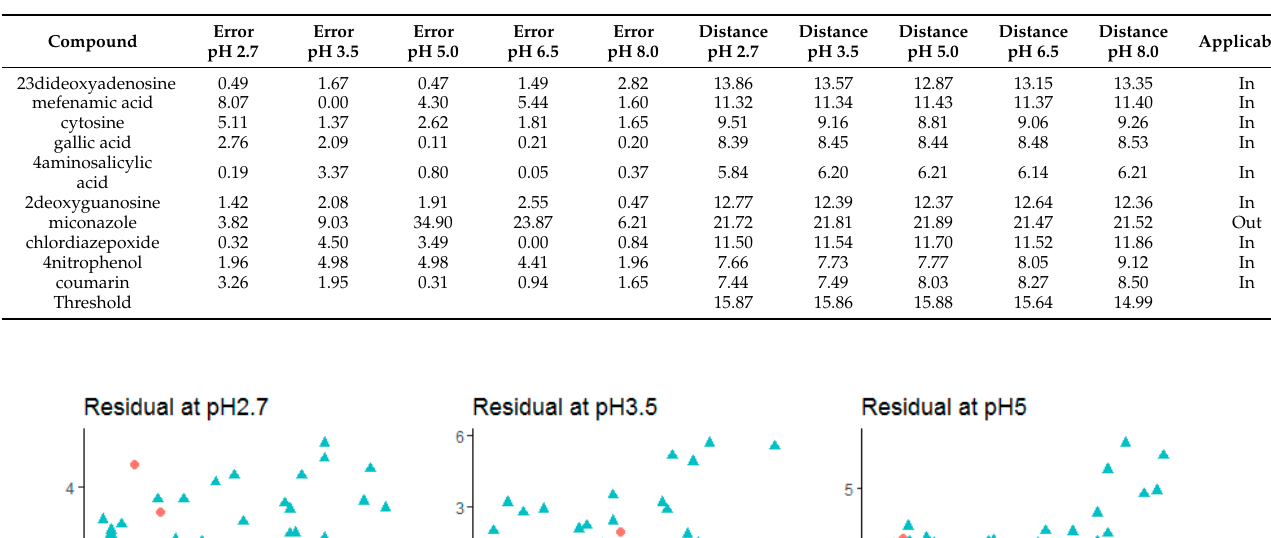
Table 6. Applicability domain calculated for each compound in test set. (Errors in columns 2,3,4,5,6 are the errors of prediction from all the models specific for compounds. Distances in columns 5,6,7,8,9 are their distances calculated using KNN fixed methods). Errors are based on back-transformed retention times (min unit).